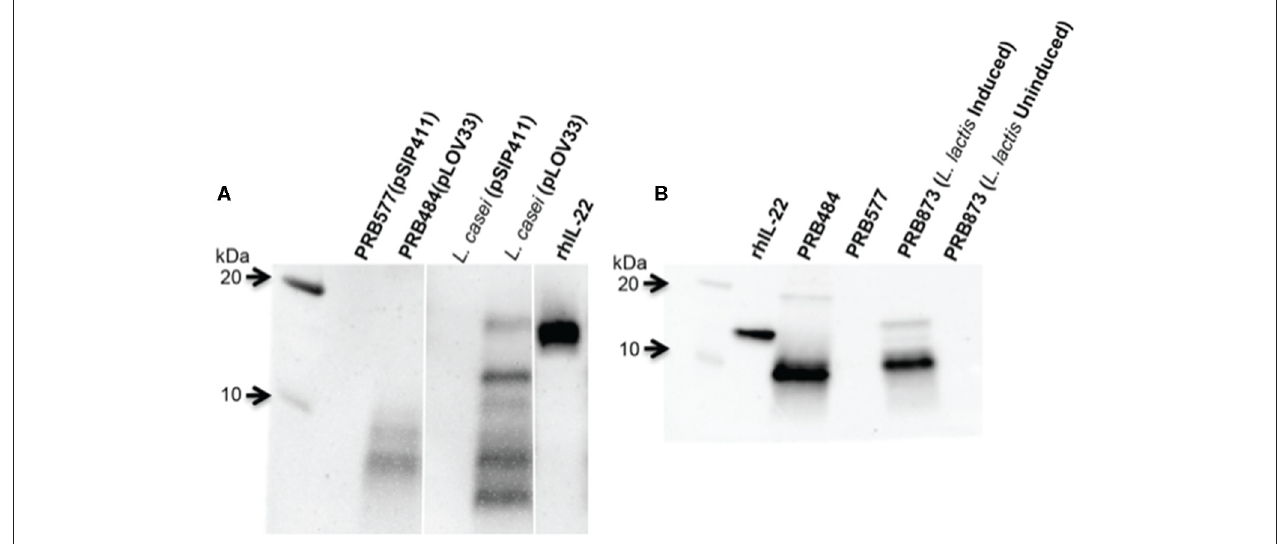
FIGURE 3 | hIL-22 is also cleaved by other Lactobacilli engineered to secrete hIL-22. (A) Western blot of hIL-22 from supernatants of L. casei harboring pLOV33 or pSIP411 showing hIL-22 secreted by L. casei is cleaved similar to L. reuteri. (B) Western blot of hIL-22 from supernatants of L. lactis harboring pLOV33 (PRB873) showing cleavage of IL-22.